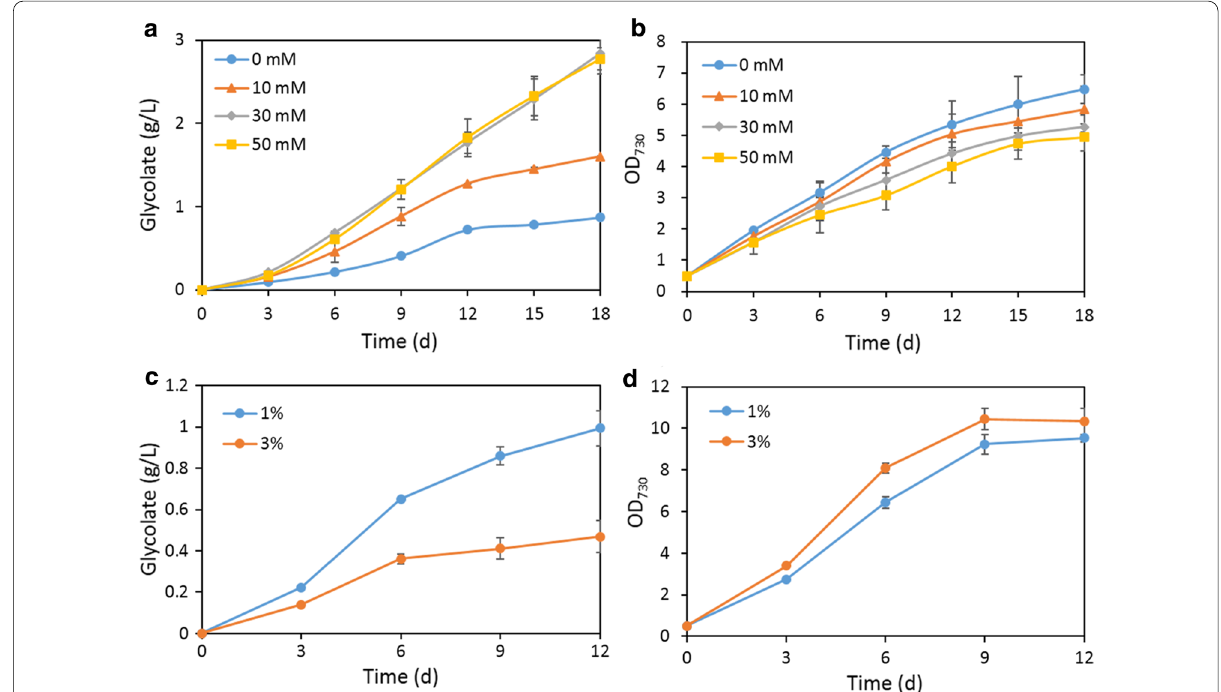
Fig. 4 Glycolate production and growth profile of strain RPE-ΔglcD with supply of NaHCO 3 or CO 2 . Cells were cultivated with different concentrations of NaHCO 3 ( a and b ) or CO 2 ( c and d ) at 30 o C under 100 µmol photons m − 2 s − 1 light intensity. Error bars represent standard deviations from biological triplicates conducted in three independent